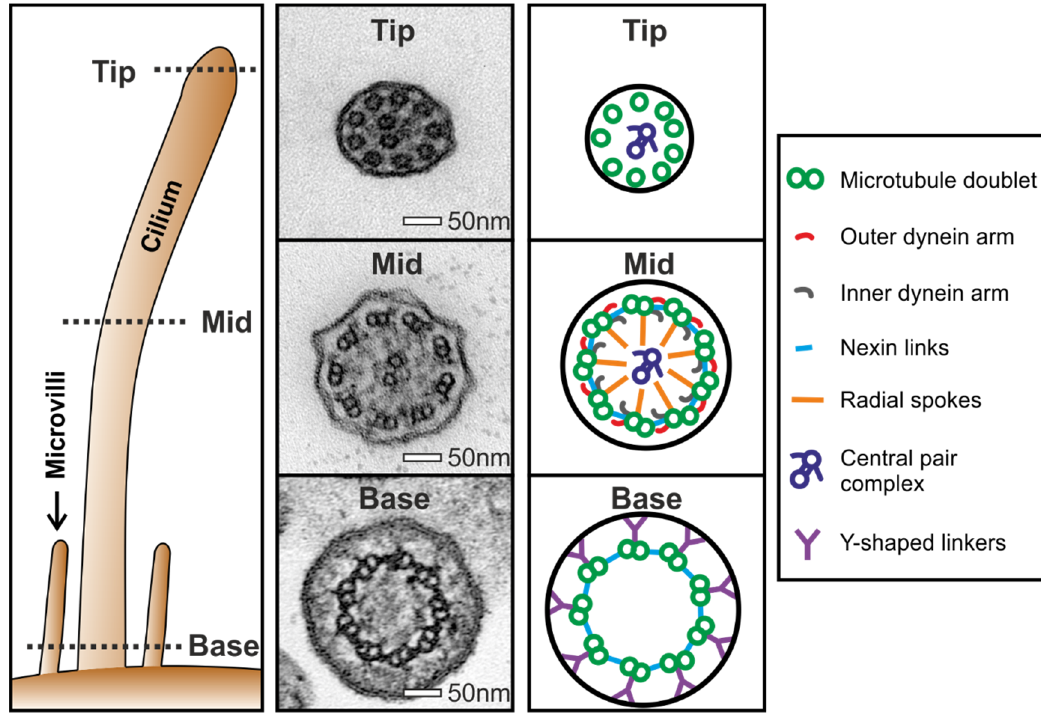
Figure 2. Ultrastructure of the different regions of a respiratory cilium. Respiratory cilia have a “9 + 2” microtubule arrangement (9 microtubule doublets and 2 single microtubules that make up the central pair), as can be seen in the mid region of the cilium. This ultrastructural arrangement runs throughout the cilium apart from at the tip and base where there are different ultrastructures, which include single microtubules and Y-shaped linkers, respectively, and an absence of dynein arms in both regions. When diagnosing PCD by TEM, it is vital to be aware of these differences in ultrastructure. In patients that have a central pair complex defect (see Figure 1b), typically the translocation of a microtubule doublet is observed at the tip, which makes it an important region of the cilium to examine.